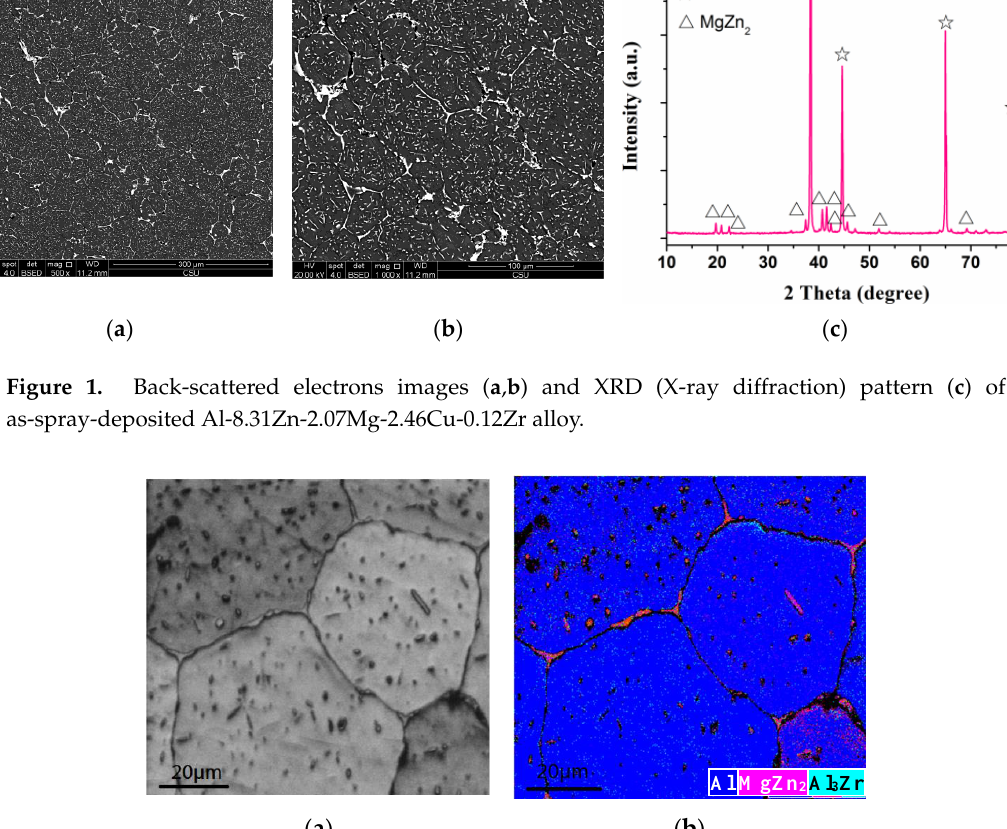
Figure 2. The SEM image and EBSD phase map of as-spray-deposited Al-8.31Zn-2.07Mg-2.46Cu- 0.12Zr alloy: ( a ) secondary electron image; ( b ) EBSD phase maps showing the detected phases and their distribution.